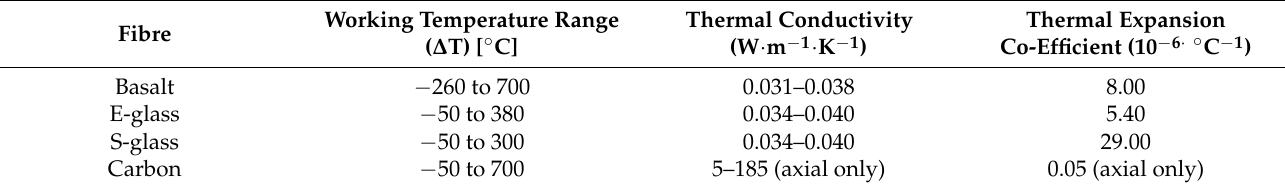
Table 3. Thermal stability of different fibres